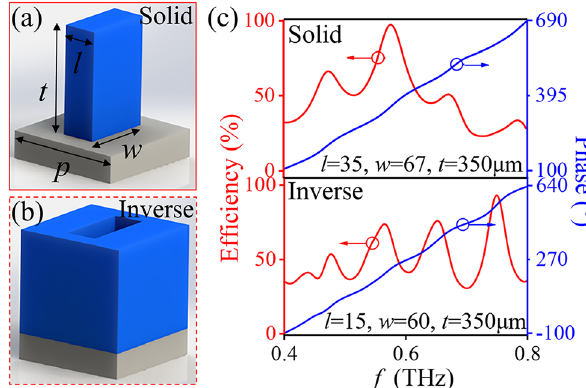
Figure 2: Phase distributions and conversion efficiencies of the solid and inverse structure. Side views of (a) a solid and (b) an inverse silicon structures with length l , width w , etching depth t , and lattice constant p on a silicon substrate. (c) Simulated phase responses (blue curves) and RCP-to- LCP polarization conversion ef fi ciencies (red curves).